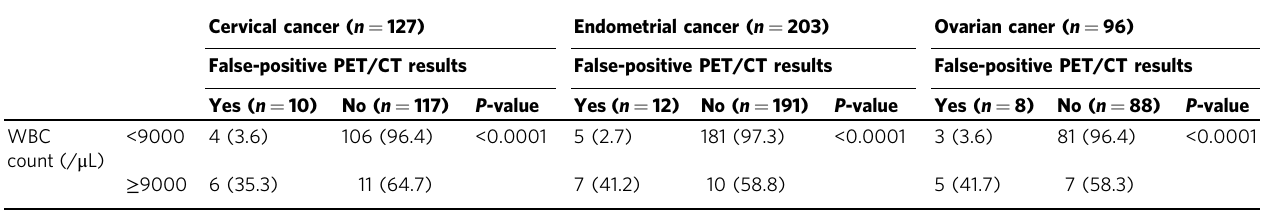
Table 2 The impact of pretreatment TRL on the diagnostic performance of 18F-FDG-PET/CT during LN staging in gynecological cancer patients (primary